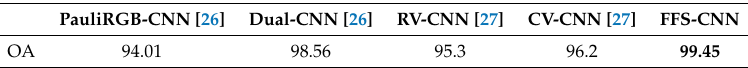
Table 4. Comparison of OAs of AIRSAR Flevoland (%).